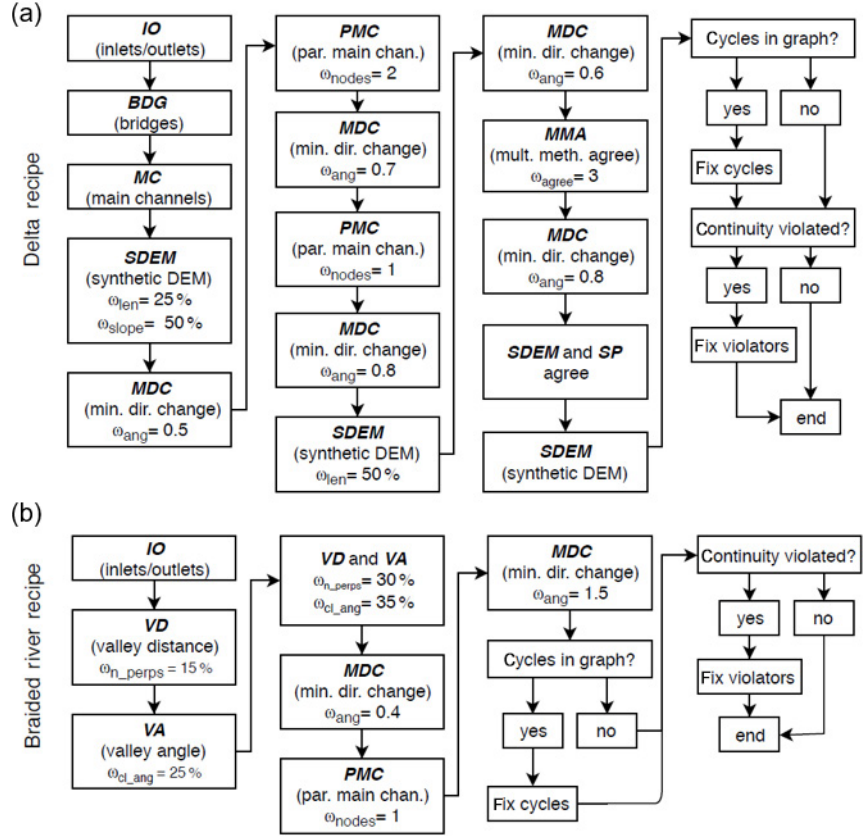
Figure 3. Recipes for setting link flow directions by chaining together DPAs. (a) Delta recipe. (b) Braided river recipe. Continuity (CON) is not explicitly represented in the diagrams, but it is applied locally after any link’s direction is set. Thresholds ( ω ) are implemented to ensure that only the most certain links are set by each DPA and are defined in Sect. 3.1. Each threshold has a different meaning that corresponds to the particular